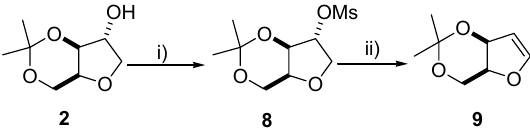
Table 2. Product yields for compounds 11a – d .